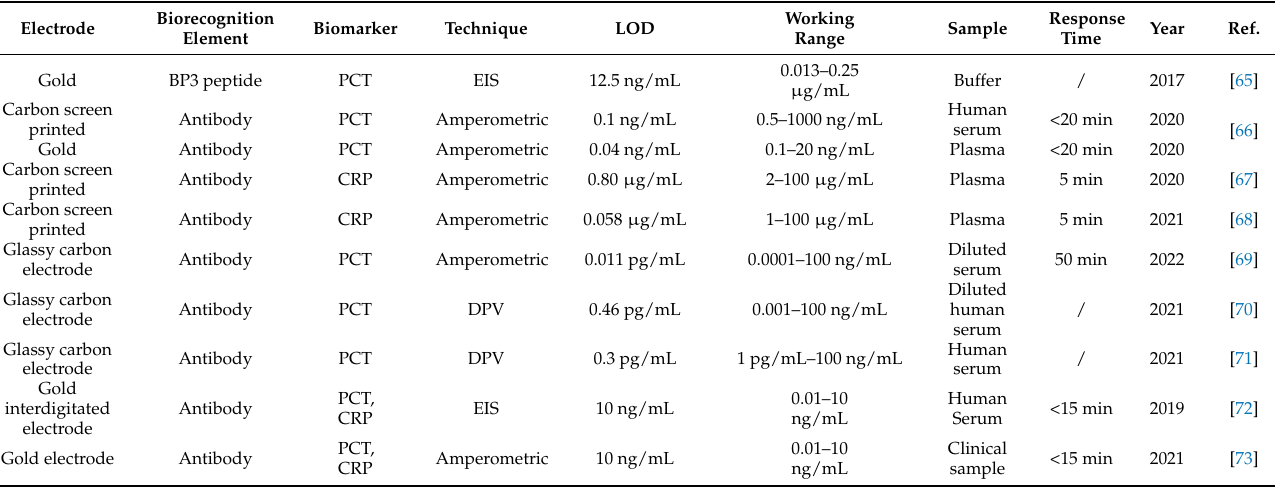
Table 2. List of electrochemical